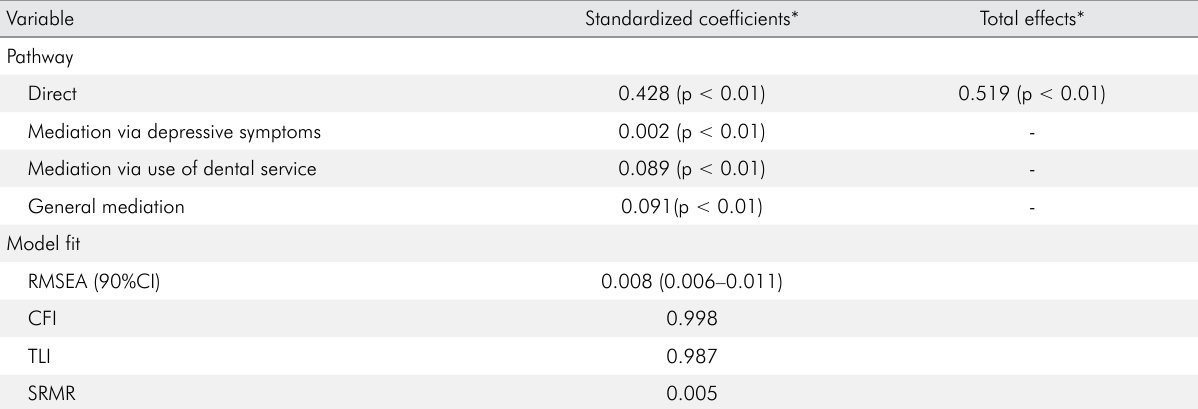
Table 2. Standardized parameters (95%CI) for direct, indirect, and total effects of socioeconomic status on oral health- related